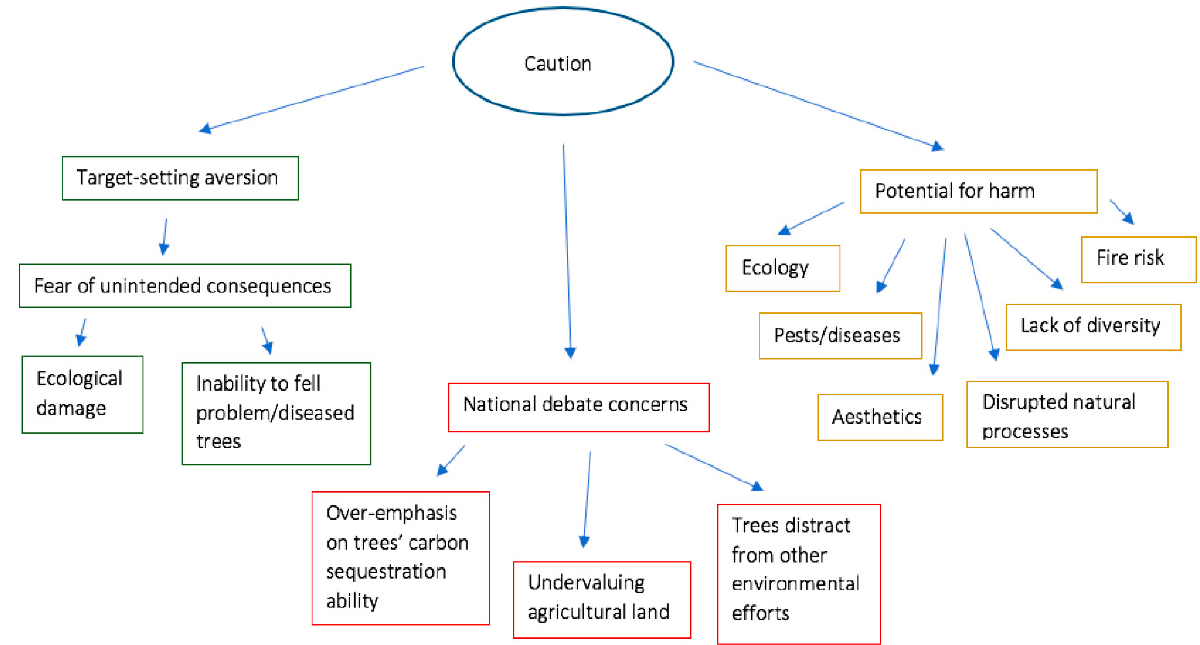
Figure 4. Thematic map of the cautions expressed by farmers and key informants discussing increasing tree cover in the Dartmoor National Park, UK.